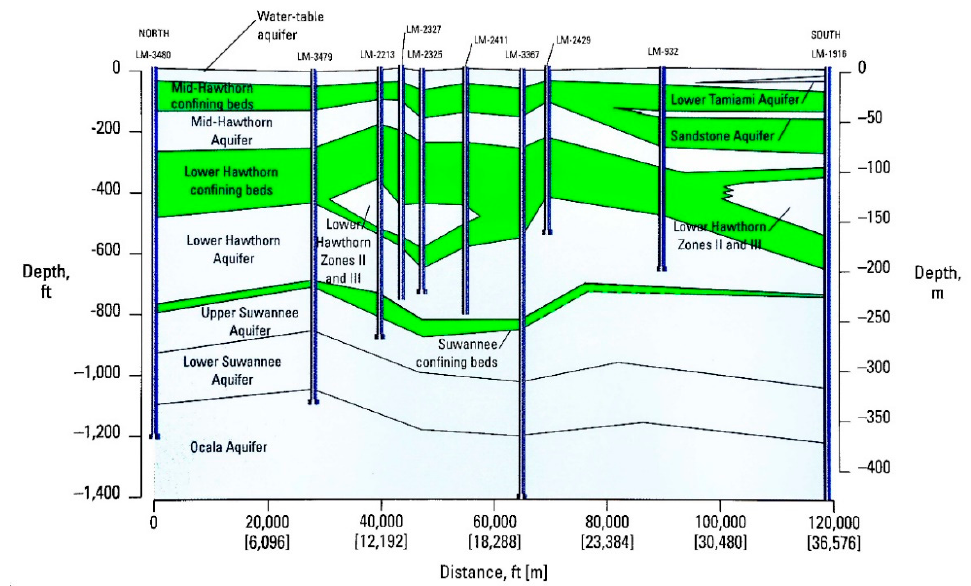
Figure 5. North–south hydrogeologic section through the City of Cape Coral showing the aquifer and confining bed locations (from [12,21]).